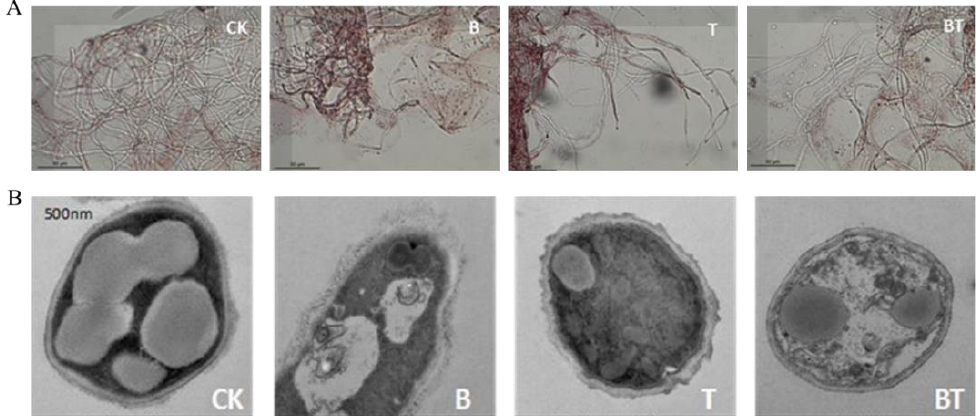
Figure 2. Effects of co-culture and axenic culture metabolites on ( A ) the structures of mycelia and ( B ) mycelia ultra-structures of F. graminearum . CK denotes control; B denotes axenic culture metabolites of B. subtilis ; T denotes axenic culture metabolites of T. atroviride ; BT denotes co-culture metabolites.